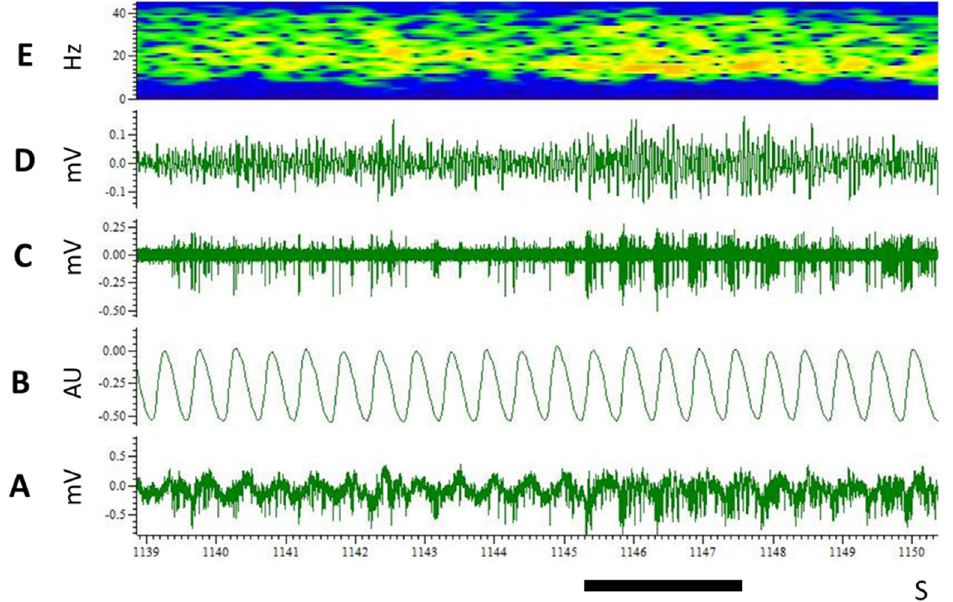
Figure 7. Simultaneous recordings of multiunit activity and local field potentials in the ventral stri-